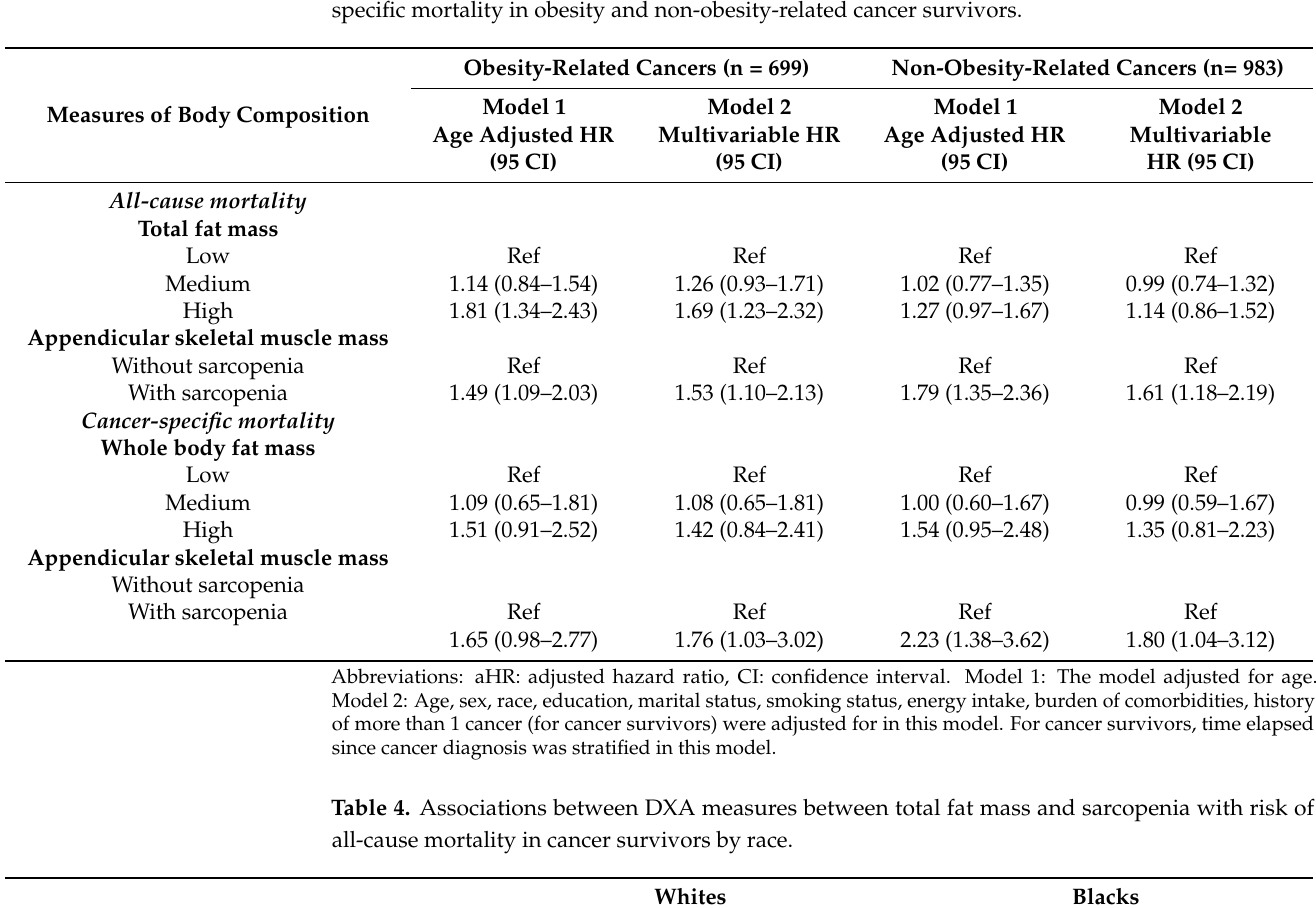
Table 3. Association between DXA measures of body composition and risk of all-cause and cancer- specific mortality in obesity and non-obesity-related cancer survivors.